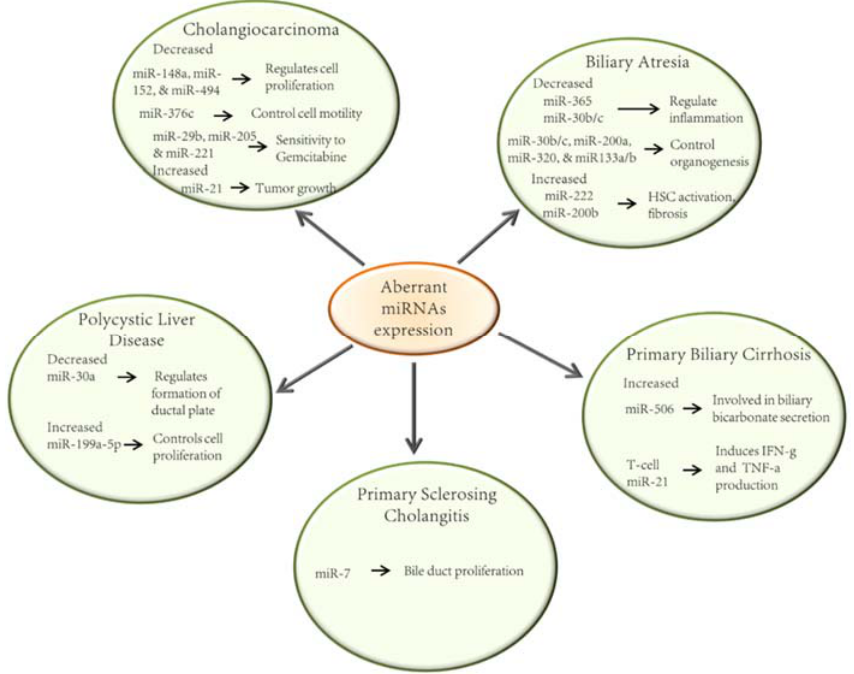
Figure 2. The roles of miRNAs on the pathogenesis of cholangiopathies. Schematic representation of the most relevant miRNAs whose expression is altered in cholangiophaties and their involvement in the pathogenesis of these diseases [31,33–35,37–45]